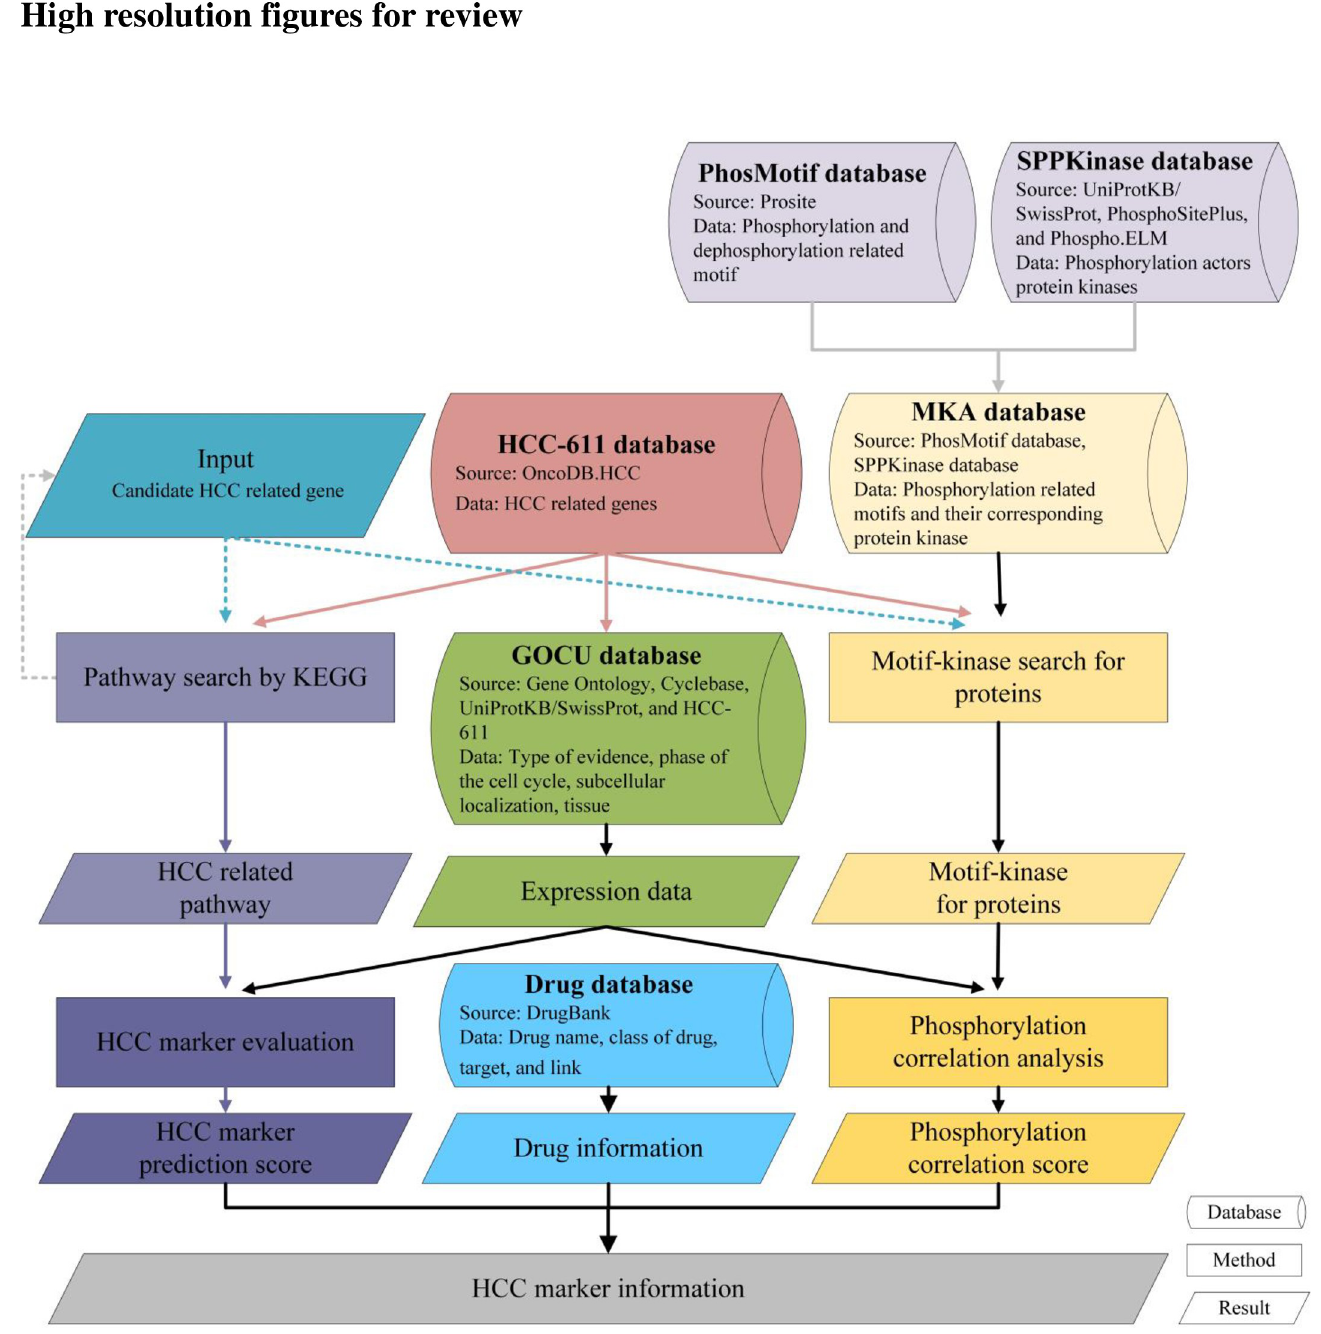
Fig 1. Flow chart of dBMHCC construction. The six developed databases are shown, along with the methods and resulting information used to generate the dBMHCC.